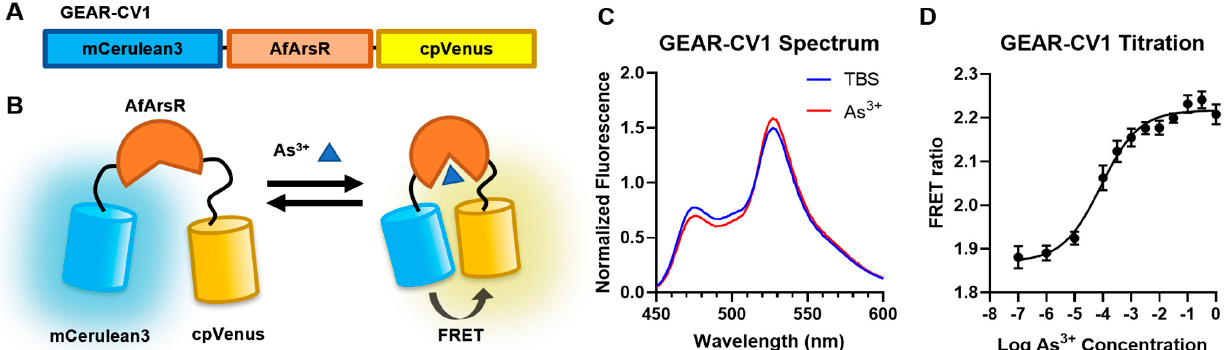
Figure 1. Design and characterization of the FRET-based As 3+ biosensor prototype GEAR-CV1. ( A ) Design and gene structure of the genetically encoded As 3+ indicator GEAR-CV1. ( B ) Schematic representation of expected FRET sensing mechanism of GEAR-CV1. ( C ) GEAR-CV1 normalized emission fluorescence spectrum (excitation at 430 nm emission scanned from 450 nm to 600 nm) in Tris-buffered saline (TBS) with (red) and without (blue) As 3+ . ( D ) FRET acceptor-to-donor fluorescence ratio (R = F 530 /F 475 ) of purified GEAR-CV1 protein when titrated with As 3+ .